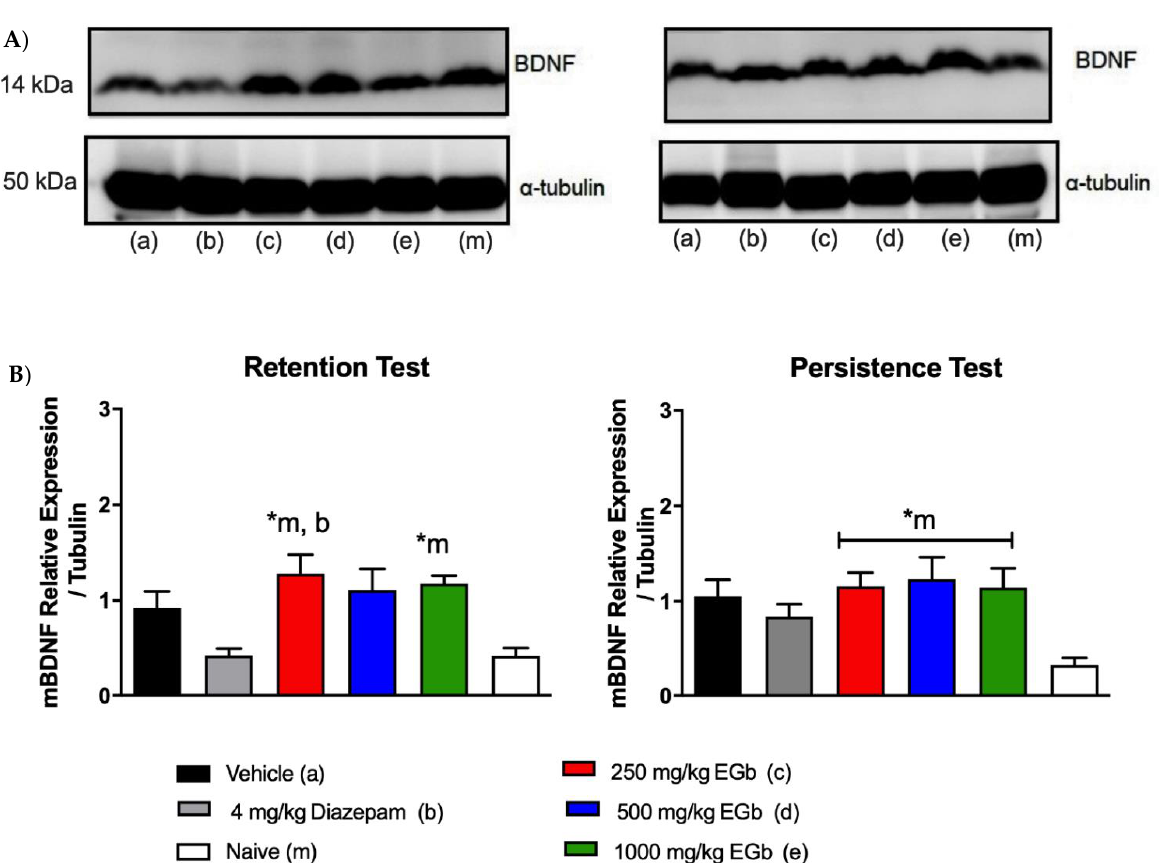
Figure 3. ( A ). Representative Western blot images. ( B ). Quantitative analysis of BDNF and α -tubulin expression in homogenates of the hippocampal formation obtained from the control (the 4 mg/kg diazepam (b), vehicle (a) and naïve (m) groups and the groups treated with EGb (250 mg/kg (c), 500 mg/kg (d) or 1000 mg/kg (e)), as determined by immunoblotting. The data were normalized to the level of α -tubulin in the retention and persistence test sessions (n = 5 rats/group). The values are presented as the mean values (± SEMs). * p < 0.05 one-way ANOVA followed by post hoc Tukey’s multiple comparison test.